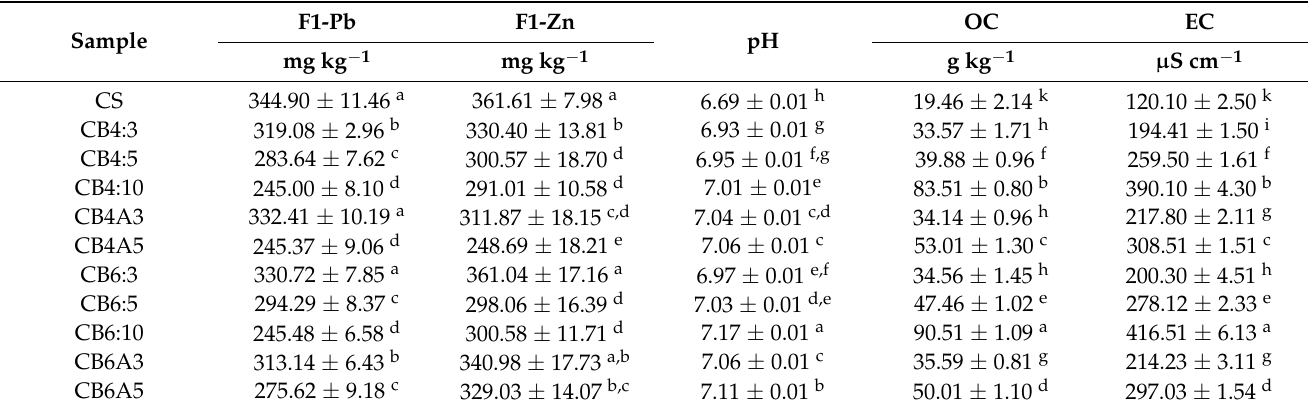
Table 2. Exchangeable fraction of Pb (F1-Pb) and Zn (F1-Zn), OC, pH, and EC after a 30-day incubation with biochar and